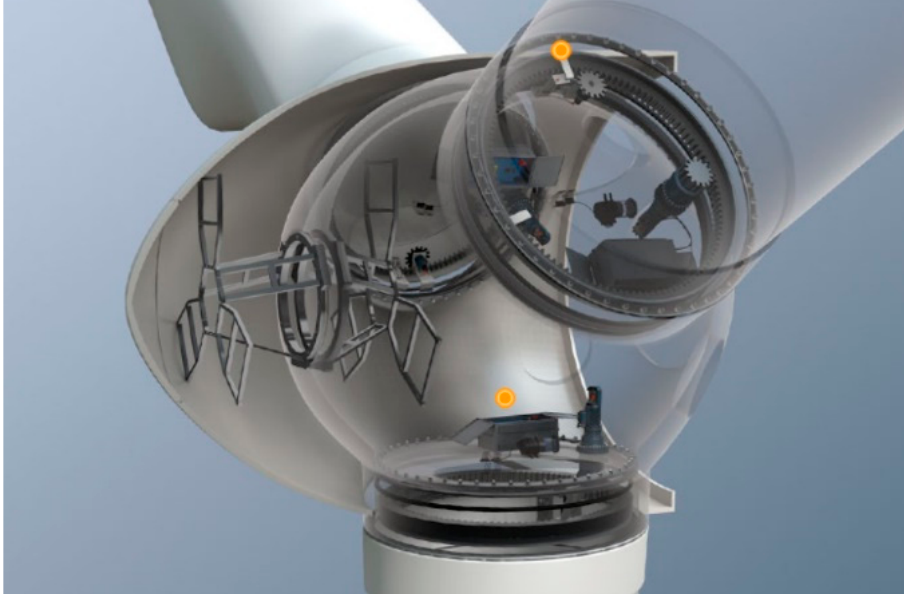
Figure 5. Construction of an electrical system for turning blades [27] .